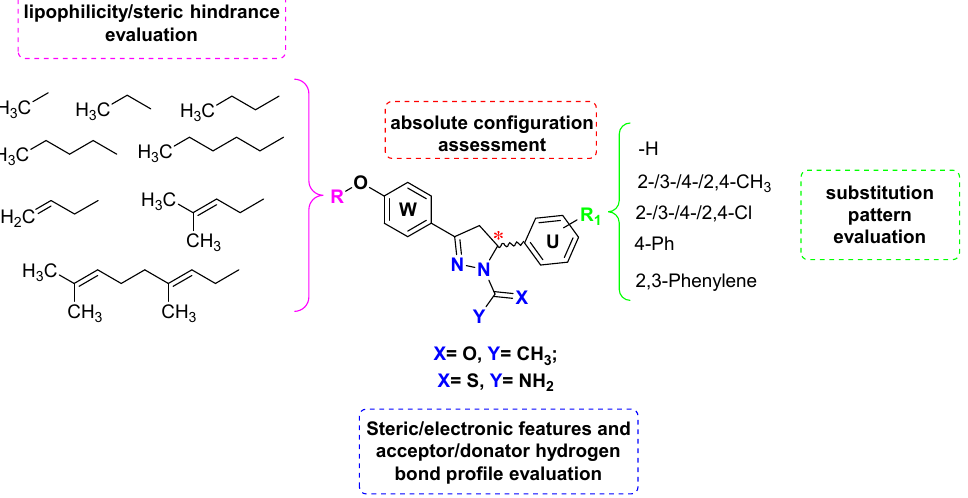
Figure 1. Design of the new pyrazoline ‐ based human monoamine oxidase (hMAO) inhibitors.